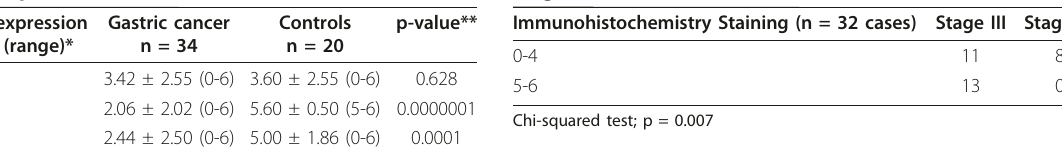
Table 4 Correlation between PKP3 expression and tumor stage